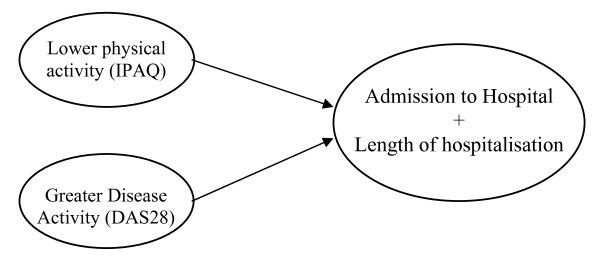
Variables associated with RA-related hospital admission over the course of a year.